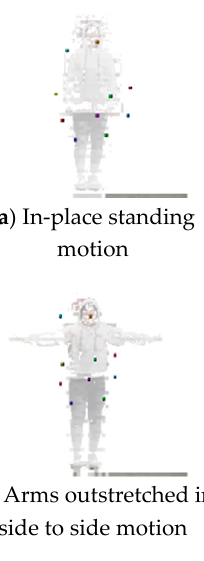
Figure 15. 3D landmarks generated when κ was 10.